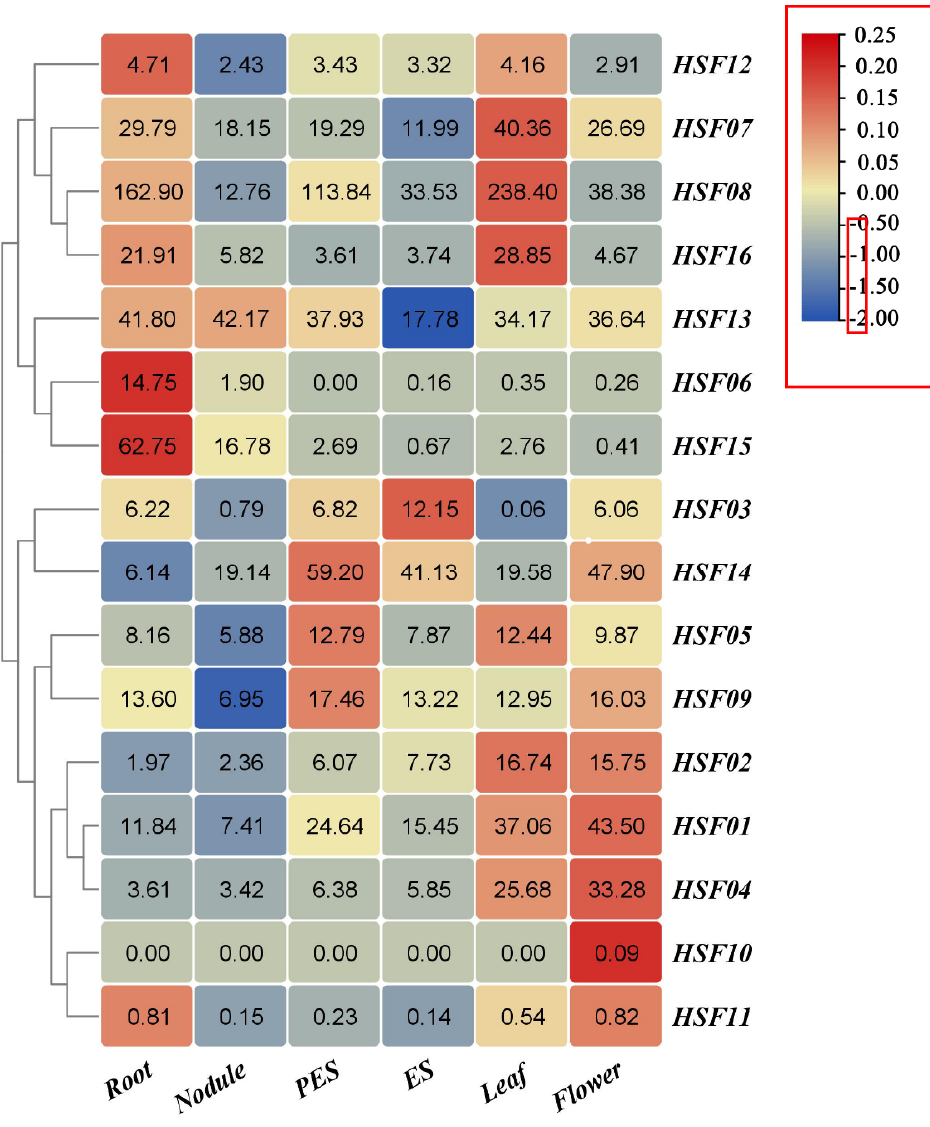
Figure 9. A heat map representation of MsHSF expression between different tissues. The values in the rectangle represent the magnitude of the gene expression.